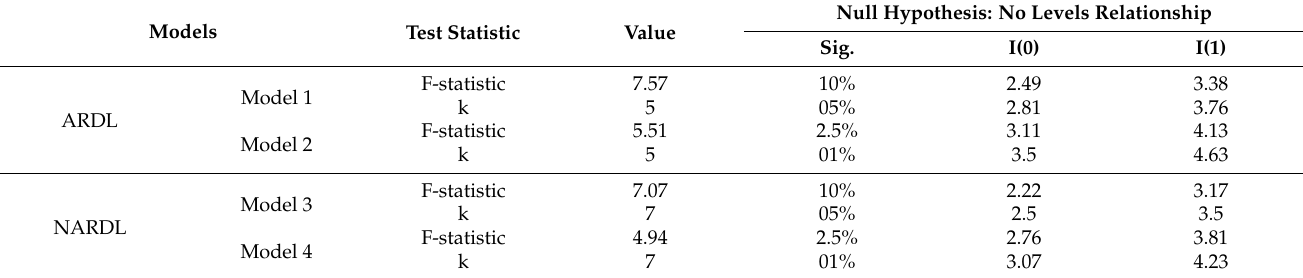
Table 4. Results of bound test.